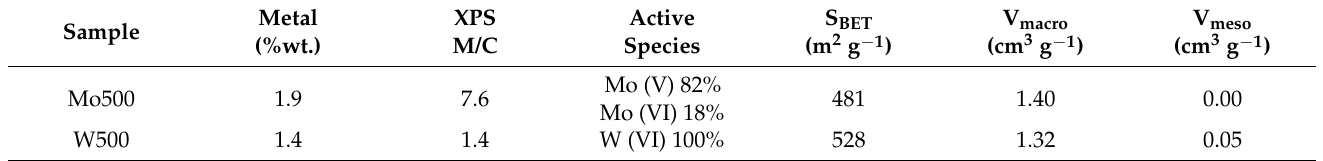
Table 1. Physicochemical properties of metal-doped carbon